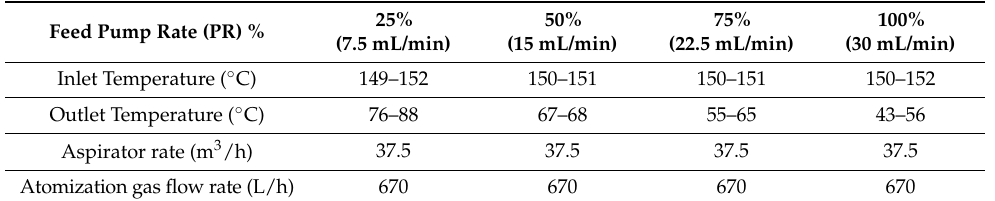
Table 1. Spray drying parameters for advanced spray-dried (SD) Fasudil powders at a feed concen- tration of 0.5% w / v from methanol (MeOH) solution in closed-mode. Feed Pump Rate (PR)